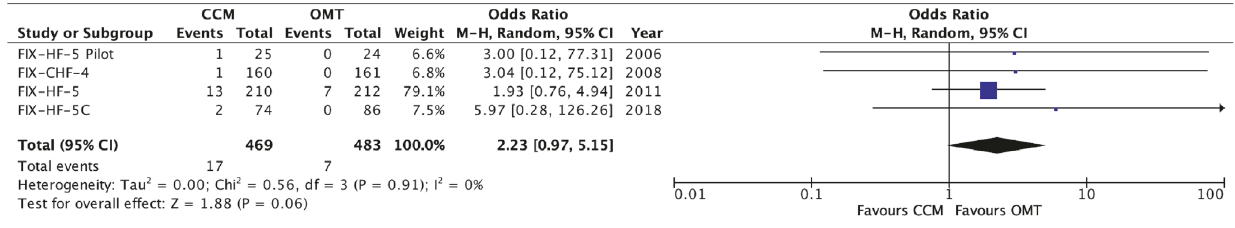
Figure 6: Forest plot of pacemaker/ICD sensing defects/malfunction in CCM groups versus the control groups. A forest plot of the data available to us from the 4 RCTs assessing pacemaker/ICD sensing defects/malfunction in those with CCM compared to those with OMT alone. There was a nonsignificant trend in increased sensing defect and malfunction in the CCM group.